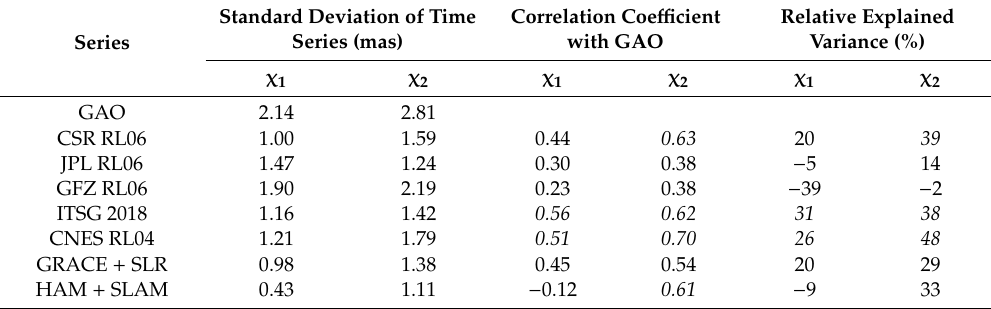
Table 9. Standard deviation of GSMAM, GAO, GRACE + SLR, and HAM + SLAM time series, correlation coe ffi cients with GAO, and percentage of variance in GAO explained by GSMAM, GRACE + SLR and HAM + SLAM. Oscillations with periods 60–100 days are considered. The critical value of the correlation coe ffi cient for 112 independent points and a confidence level of 0.95 is equal to 0.15. A standard error of a di ff erence between two correlation coe ffi cients for 112 independent points is equal to 0.14. The highest values of correlations and relative explained variances are